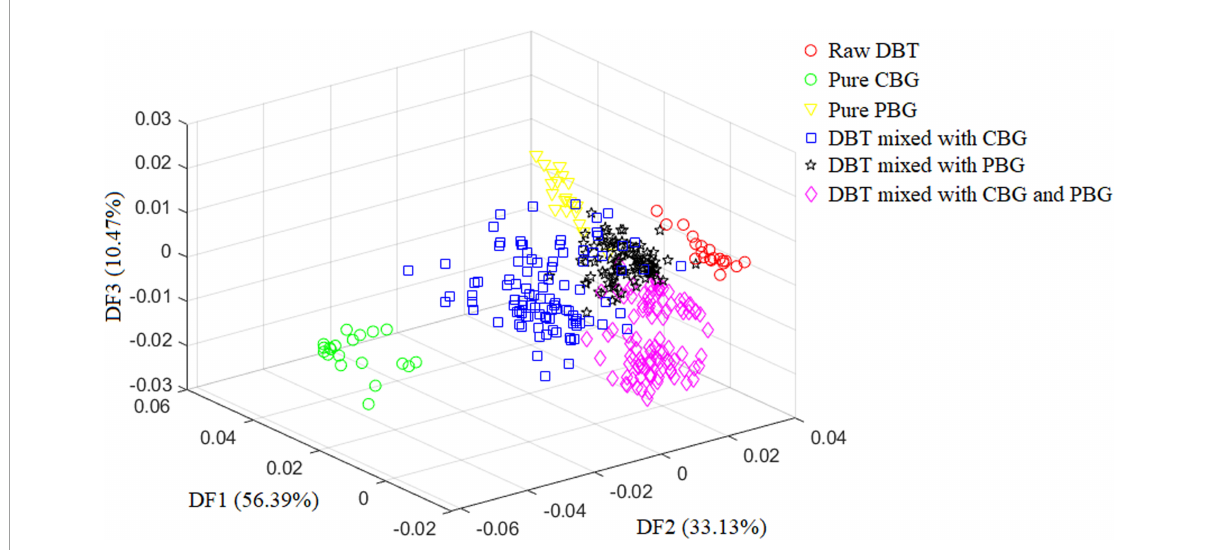
FIGURE2 The scatter diagram of the discriminate scores of the training set samples for the optimal Fisher LDA model. DBT, Duck blood tofu; CBG, cow blood-based gel; PBG, pig blood gel.